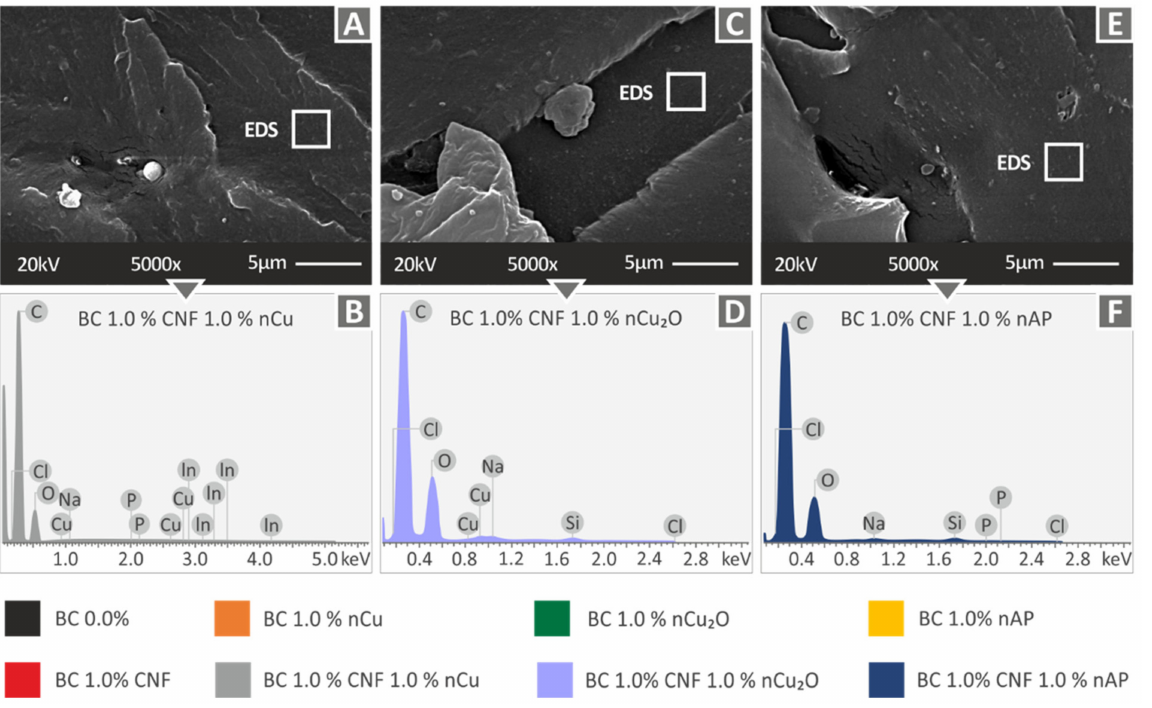
Figure 8. ( A ) Biomed Clear 1 wt.% CNF and 1 wt.% Cu SEM image with 5000 × magnification of tensile test specimen’s fracture surface, ( B ) Biomed Clear 1 wt.% CNF and 1 wt.% Cu EDS graph, ( C ) Biomed Clear 1 wt.% CNF and 1 wt.% Cu 2 O SEM image with 5000 × magnification of tensile test specimen’s fracture surface, ( D ) Biomed Clear 1 wt.% CNF and 1 wt.% Cu 2 O EDS graph, ( E ) Biomed Clear 1 wt.% CNF and 1 wt.% Antibacterial SEM image with 5000 × magnification of tensile test specimen’s fracture surface, and ( F ) Biomed Clear 1 wt.% CNF and 1 wt.% Antibacterial EDS